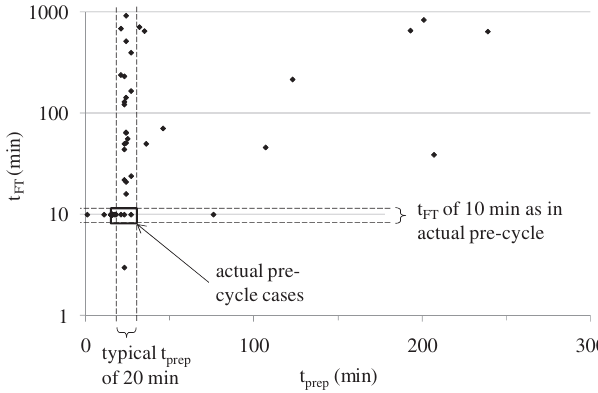
FIG. 9. Precycle parameters used for each ramp in the LHC during May–June 2011. Each point represents a ramp.